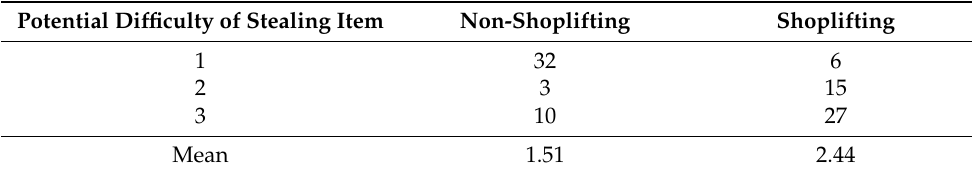
Table 7. Difficulty of stealing item.